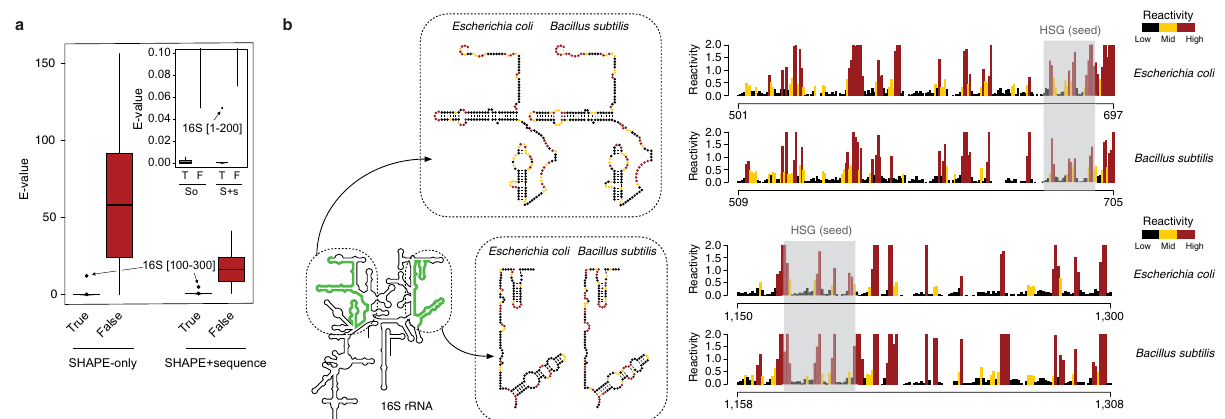
Fig. 2 Validation of SHAPEwarp. a Box-plot depicting the distribution of E-values for true (T) and false (F) matches for E. coli 16S rRNA searched against B. subtilis 16S/23S rRNAs, both in SHAPE-only (So) and SHAPE + sequence (S + s) mode. Boxes span the 25th to the 75th percentile. The center represents the median. Values below the 25th percentile − 1.5 times the IQR, or above the 75th percentile + 1.5 times the IQR, represent outliers and are reported as dots. The inset shows a zoom-in view of the box-plot for E-values between 0 and 0.1. Sample sizes are as follows: n = 15 (SHAPE only) and n = 16 (SHAPE + sequence) for true matches, and n = 1338 (SHAPE only) and n = 457 (SHAPE + sequence) for false matches. b Sample alignments for two matching regions between the 16S rRNAs of E. coli and B. subtilis , as identi fi ed by SHAPEwarp. SHAPE reactivities have been capped to 2. The high scoring group (HSG), constituting the seed of the alignment, is shaded in gray. The insets show the same two regions in their structural